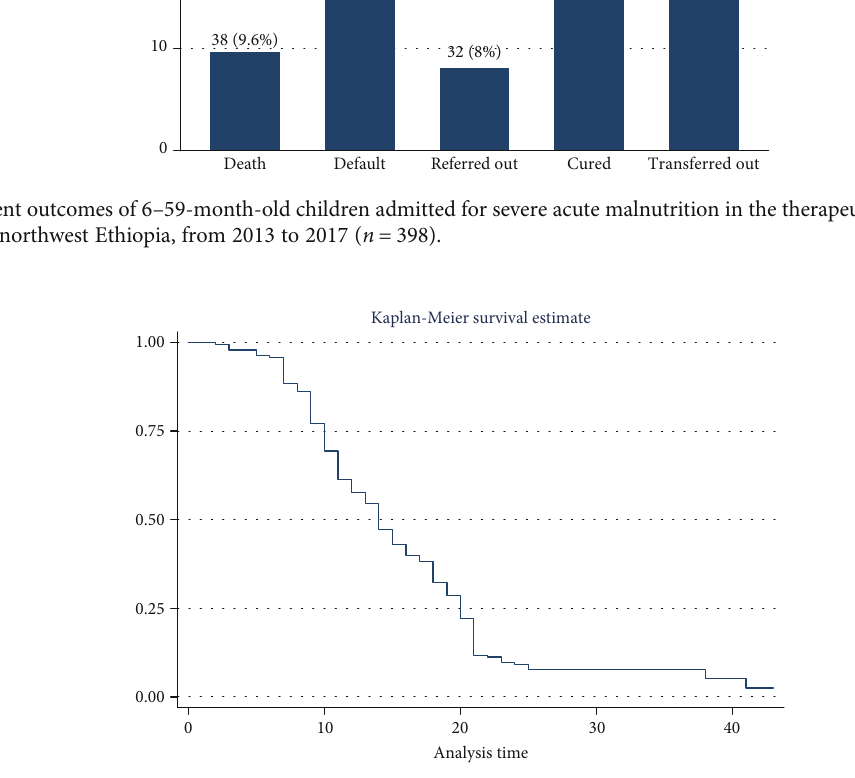
Figure 3: Overall median recovery time of the entire cohort in the therapeutic feeding center at Pawi General Hospital, northwest Ethiopia, from 2013 to 2017. Table 4: Recovery time and rate from SAM by predictors of among children with SAM managed at Pawi General Hospital from 2013 to 2017.